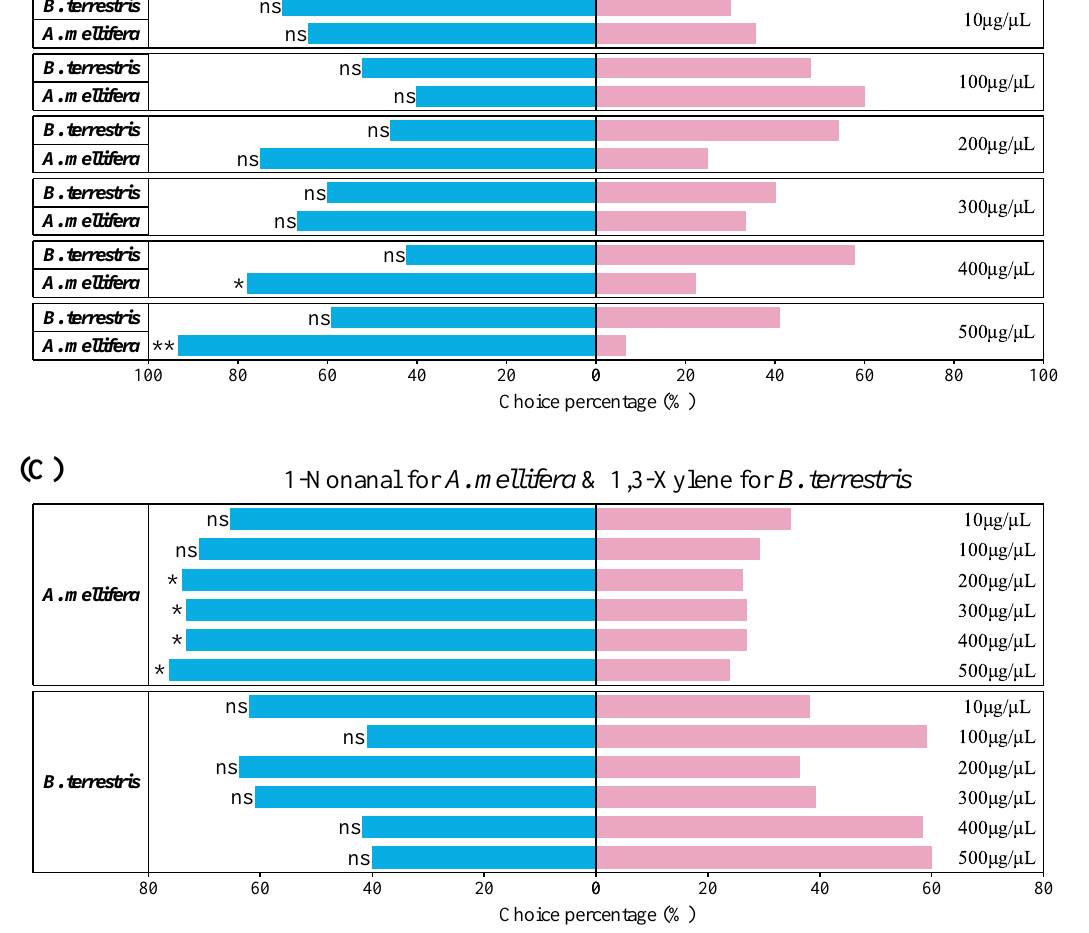
Figure 2. Y-tube behavior choices of bees towards different compounds at different concentrations. ( A ) The choice percentage of B. terrestris and A. mellifera to toluene (ns: p > 0.05). ( B ) The choice percentage of B. terrestris and A. mellifera to (+)-dihydrocarvone (ns: p > 0.05; * 0.01 < p < 0.05, and ** 0.001 < p < 0.01). ( C ) The choice percentage of A. mellifera to 1-nonanal and B. terrestris to 1,3-xylene (ns: p > 0.05; * 0.01 < p <